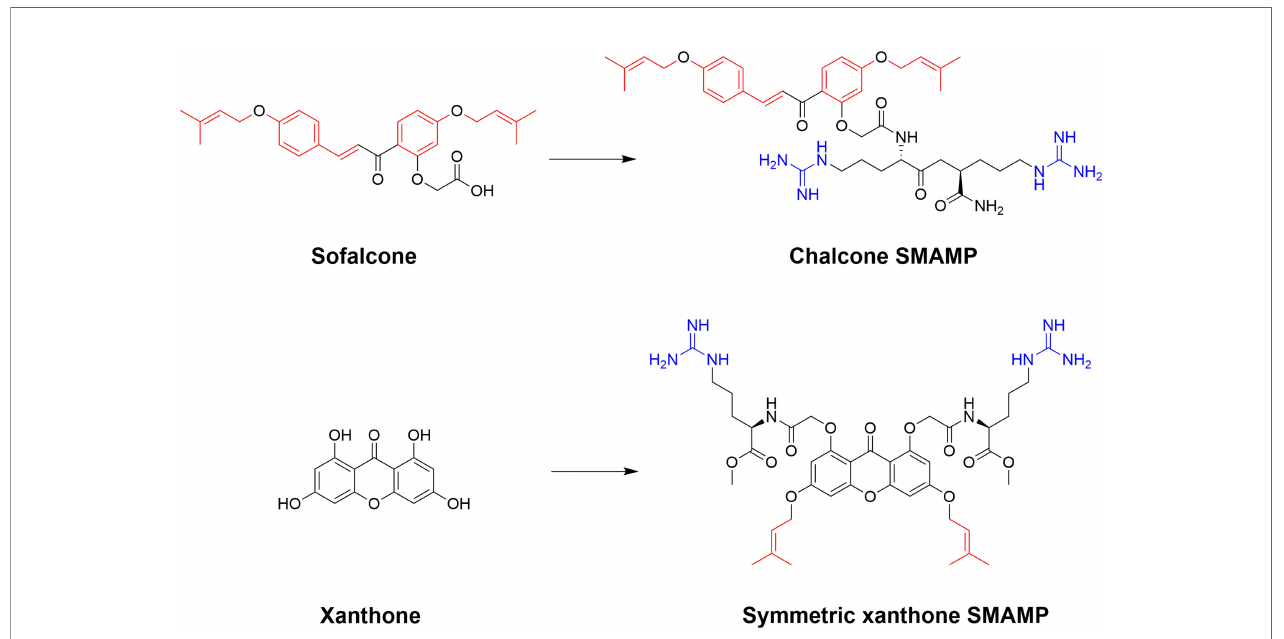
FIGURE 13 | Examples of ways to functionalize natural scaffolds from plants into potent SMAPs. Both chalcones and xanthones offer ample opportunity for synthetic modi fi cation to introduce both cationic and hydrophobic residues to achieve the essential balance for high antimicrobial activity and low mammalian cytotoxicity (160,